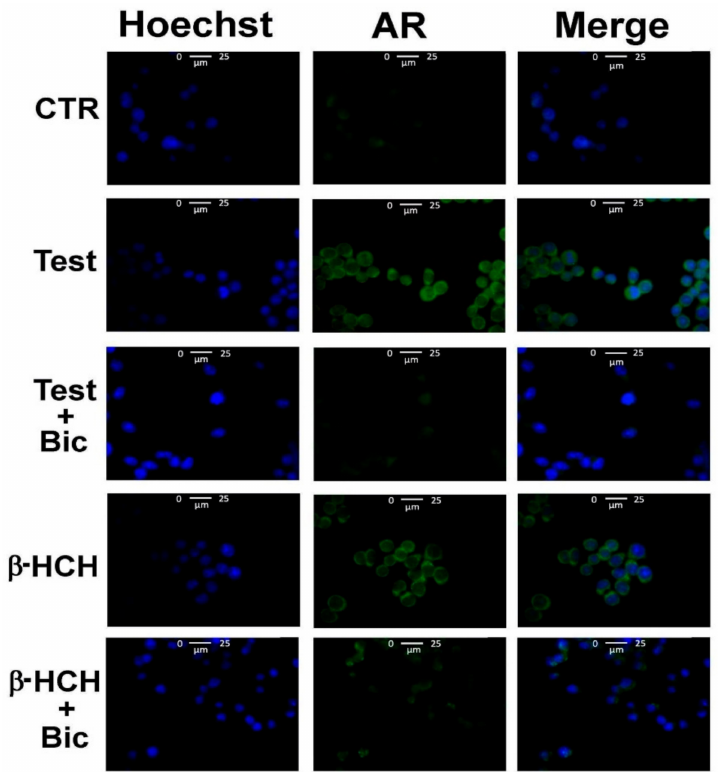
Figure 2. Cellular distribution of AR followed by immunofluorescence in LNCaP cells. CTR: Control untreatedcells; Test: Cellssubjectedtoa4-hstimulationwith30nMtestosterone; β -HCH:Cellssubjected to a 4 h stimulation with 10 µ M β -HCH; Bic: Cells treated overnight with 120 nM bicalutamide. Samples referring to the images in the third and fifth rows of the panel (“Test + Bic” and “ β -HCH + Bic”) were pretreated overnight with 120 nM bicalutamide and then subjected to a 4 h stimulation with β -HCH or testosterone AR nuclear localization induced by both β -HCH and testosterone, as evidenced by the images in the second and fourth rows, results inhibited by bicalutamide